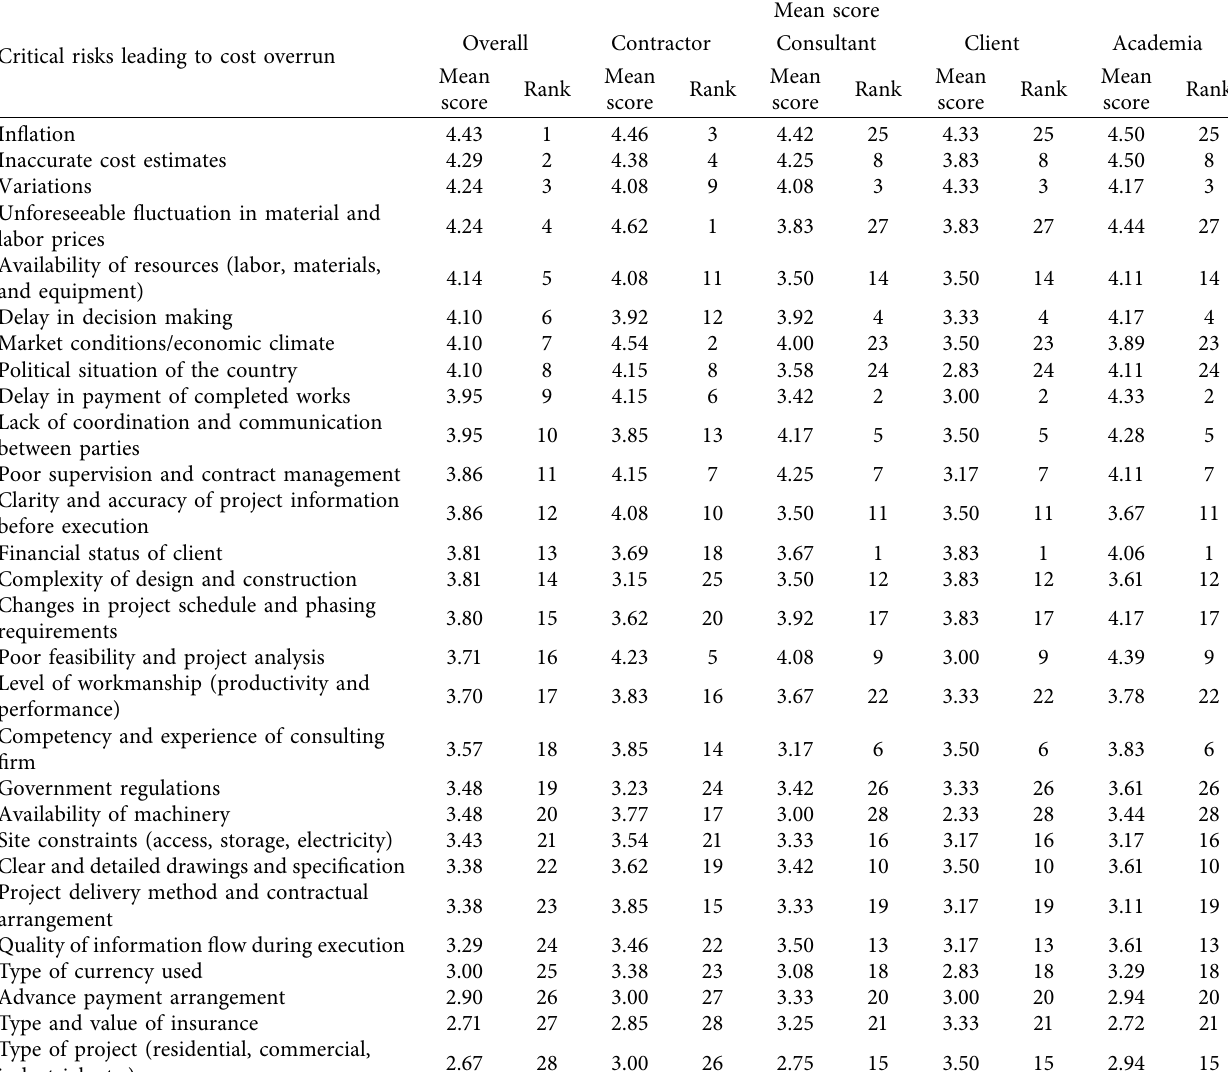
Table 7: Critical risks leading to cost overrun in construction